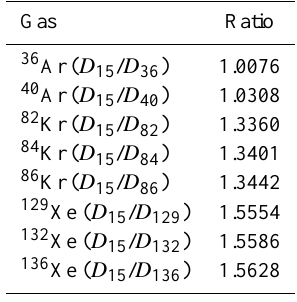
Table 1. Molecular diffusivity ratios used in this